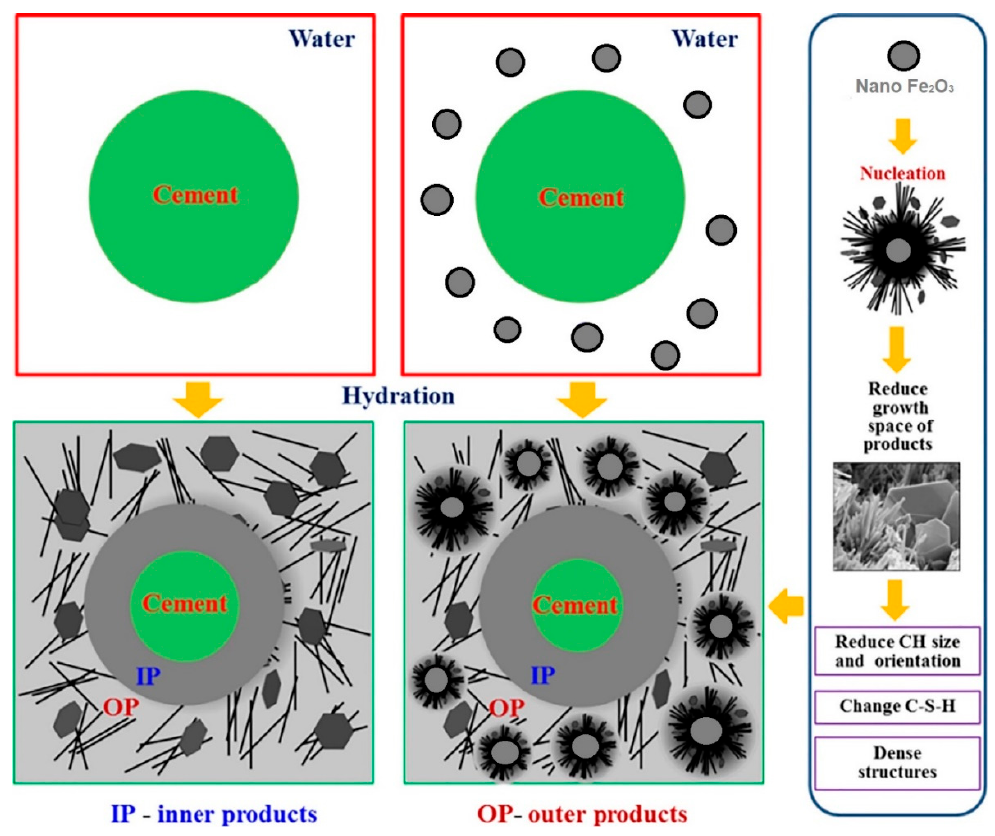
Figure 13. Models of influence of nano-Fe 3 O 4 on the hydration products’ growth, based on Lee et al. (Reprinted with permission from [42]. Copyright 2018 Elsevier).